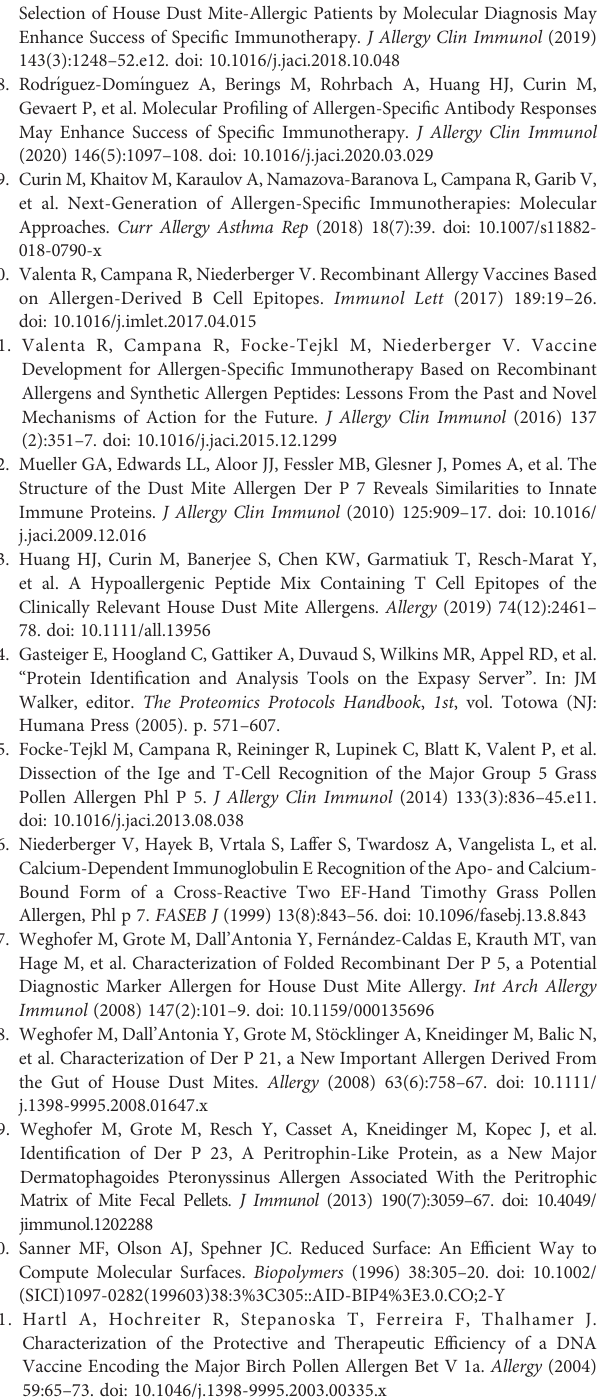
Supplementary Figure 3 | Immunization with Der p 7-derived peptides induces Der p 7-speci fi c antibodies in rabbits. Rabbits were immunized with KLH-coupled Der p 7-derived peptides adsorbed to alum (2 rabbits per peptide) or to CFA (2